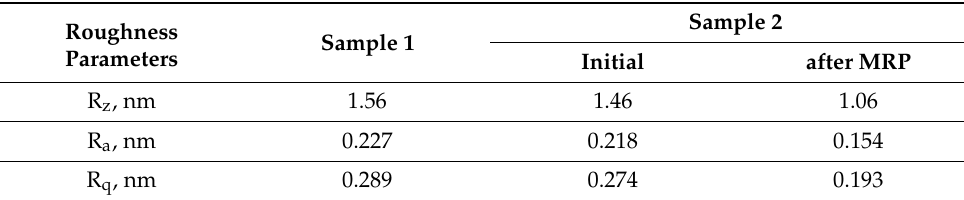
Table 3. Surface roughness parameters of the